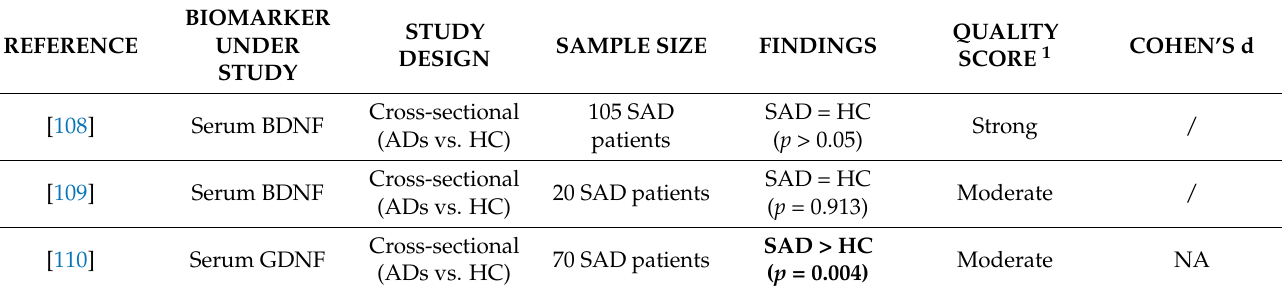
Table 5. Summary of findings regarding neurotrophic markers of